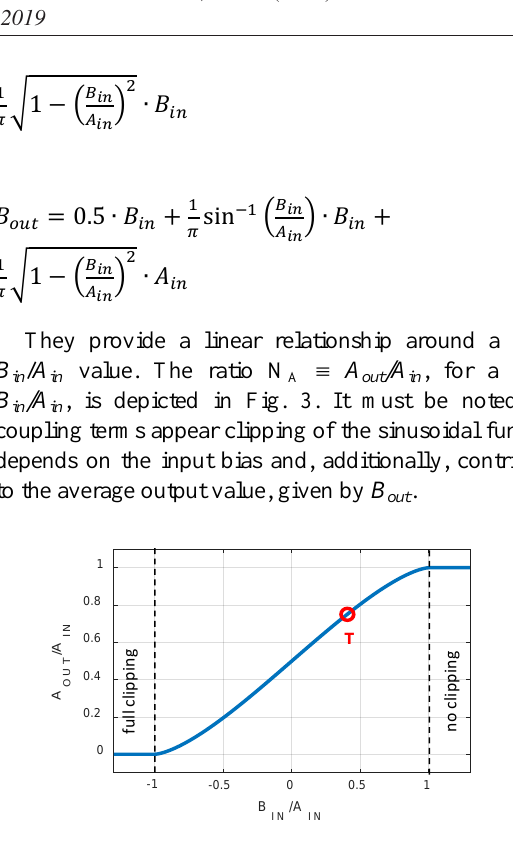
Fig. 3. I/O gain of the sinusoidal term,